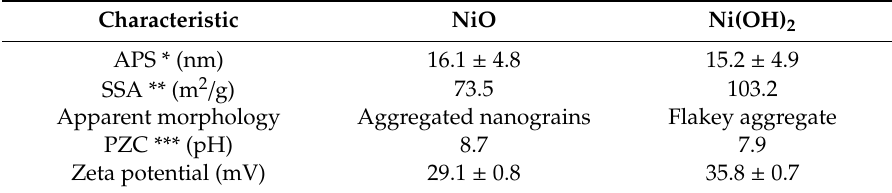
Table 1. Physical characteristics of NiO and Ni(OH) 2 NPs. Data are expressed as mean ± SD.